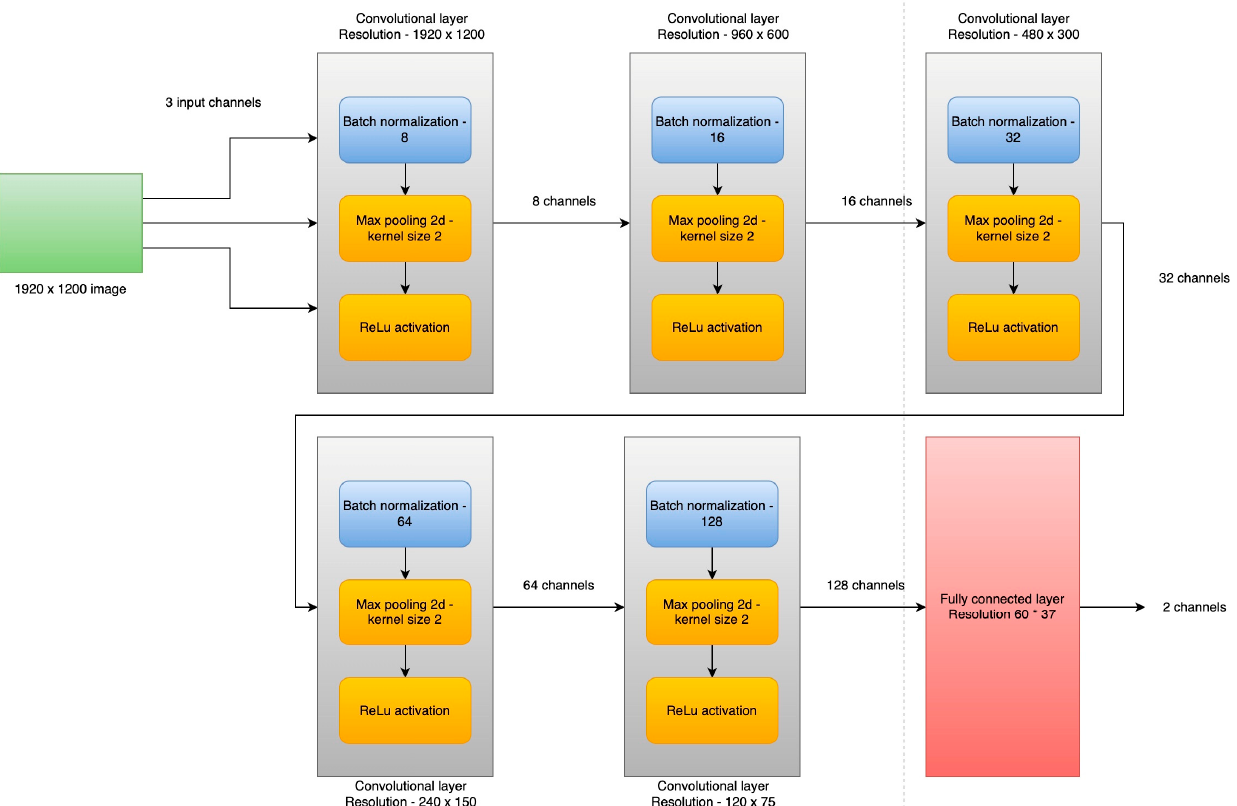
Figure 7. Convolutional network architecture.